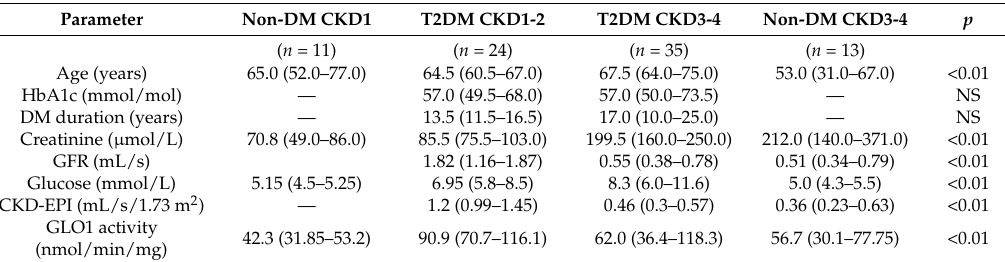
Table 1. Clinical characteristics of the